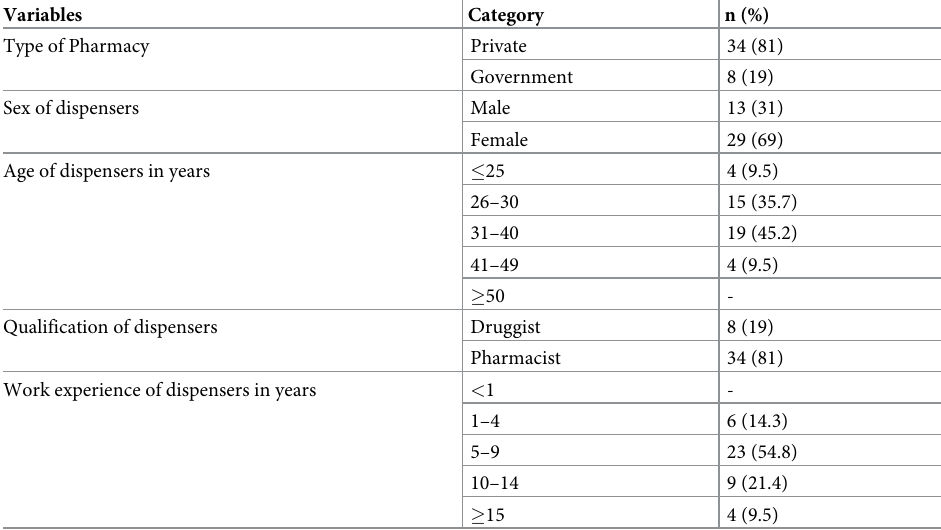
Table 1. Characteristics of dispensers and types of Pharmacy at Adama, Oromia, Ethiopia, March 2018 to June 2018 (N =